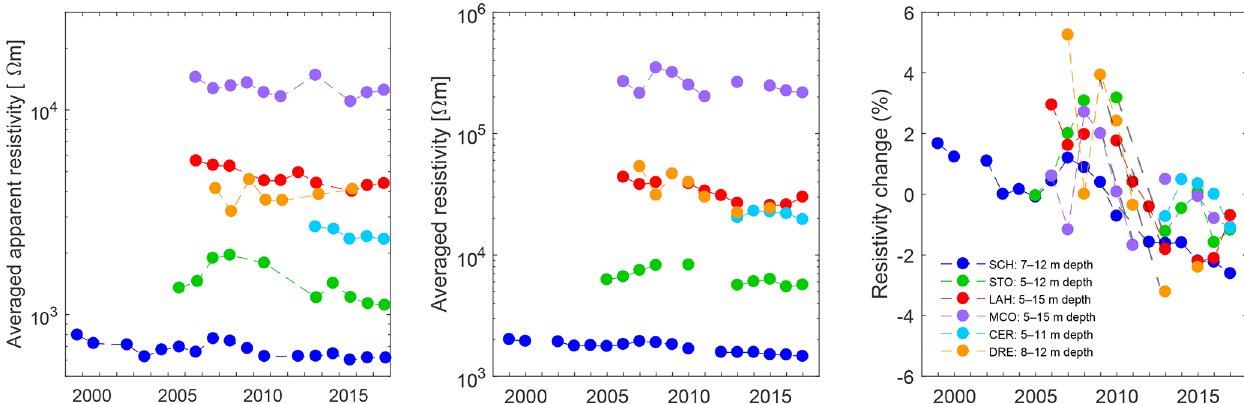
Figure 10. Time series of the end-of-summer permafrost selected zone of (a) spatially averaged apparent resistivity, (b) spatially averaged resistivity logarithm, and (c) logarithm resistivity changes relative to the median of the end-of-summer time series. End-of-summer represents the second half of August, with extreme dates ranging between mid-July and mid-September for years without an end-of-August dataset. The grey dashed lines highlight the period ( ∼ 2009–2013) of remarkable resistivity decrease at all